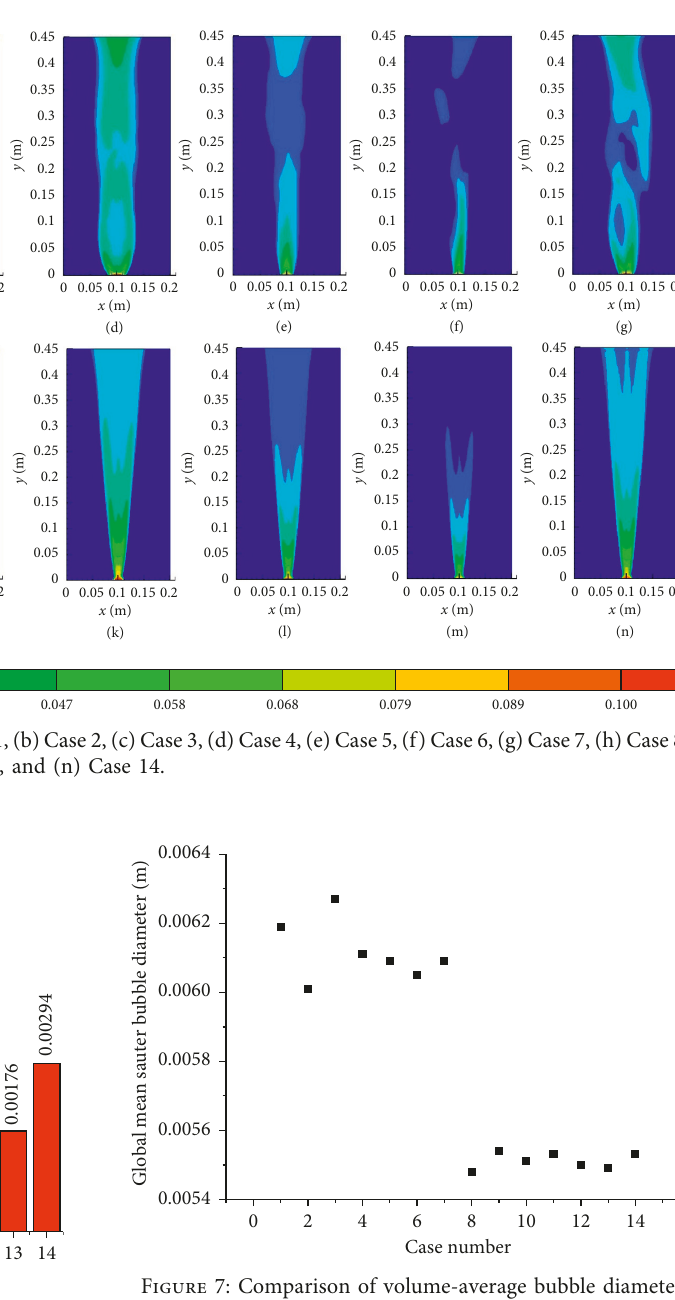
Figure 6: Comparison of gas holdup.